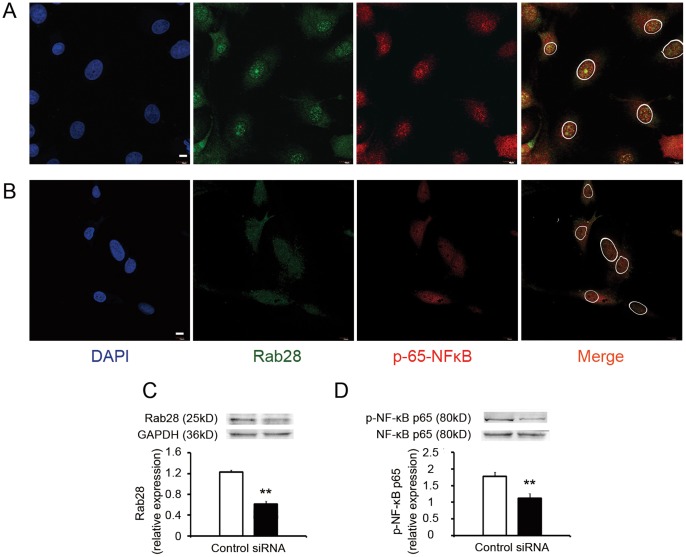
Decrease of Rab28 expression attenuated activation of NF-κB in ECs.(A) As a control, ECs were incubated with Lipofectamine 2000 and negative control siRNA. Then cells were stimulated with 10−6 mol/L Ang II for 30 minutes. Fluorescence microscopy showed the translocation of NF-κB from cytoplasm into nucleus (activation) was significant. (B) ECs were incubated with Lipofectamine 2000 and target siRNA of Rab28. Then cells were stimulated with 10−6 mol/L Ang II for 30 minutes. Fluorescence microscopy showed the attenuated Rab28 expression and NF-κB translocation. (A) and (B) were photographed with the same exposure time. Scale bars: 10 µm. (C) siRNA effectively knocked down the expression of Rab28. (D) After the knockdown of Rab28, the phosphorylation of NF-κB p65 (activation) were significantly attenuated. All results are given as mean ± s.d., **P<0.01, n = 7 each.